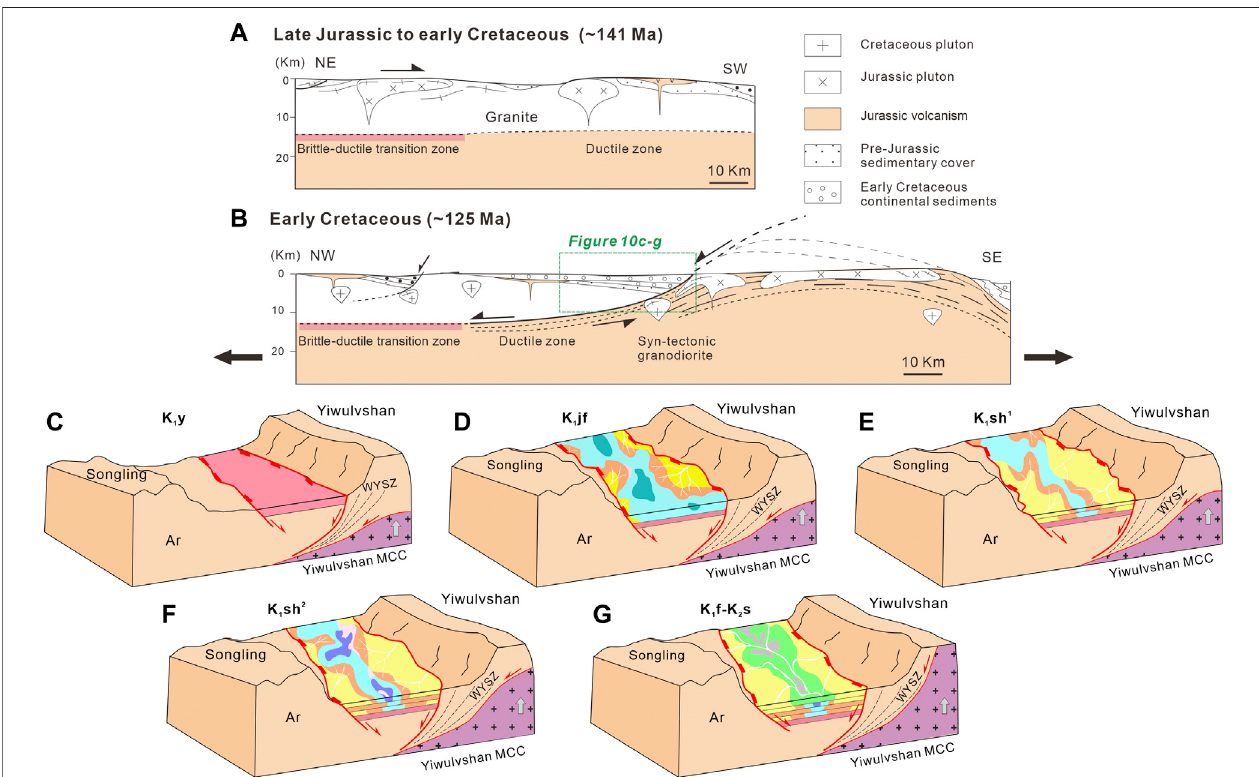
FIGURE 10 | Model of the evolution of the Fuxin Basin, NE China. (A,B) Tectonic evolution of the Yiwulvshan MCC from compression to extension (modi fi ed after Linetal.,2013). (C) EarlyCretaceous(ca.125 Ma)syn-tectonicmagmatismgeneratedisostaticreboundthatresultedinabandonmentoftheinitialbreakawayanddome formation. (D) The Fuxin Basin expanded during deposition of the Jiufotang Formation, with a lacustrine sedimentary environment prevailing in the basin. (E) Extension intensi fi ed, and lakes reduced in area and depth, leading to only limited areas of lacustrine conditions in the basin. (F) The Fuxin Basin expanded and formed an extensive area of moderately deep-lacustrine facies. (G) Activity of the MCC ceased, the Fuxin Basin stopped expanding, and the lacustrine sedimentary environment was terminated.